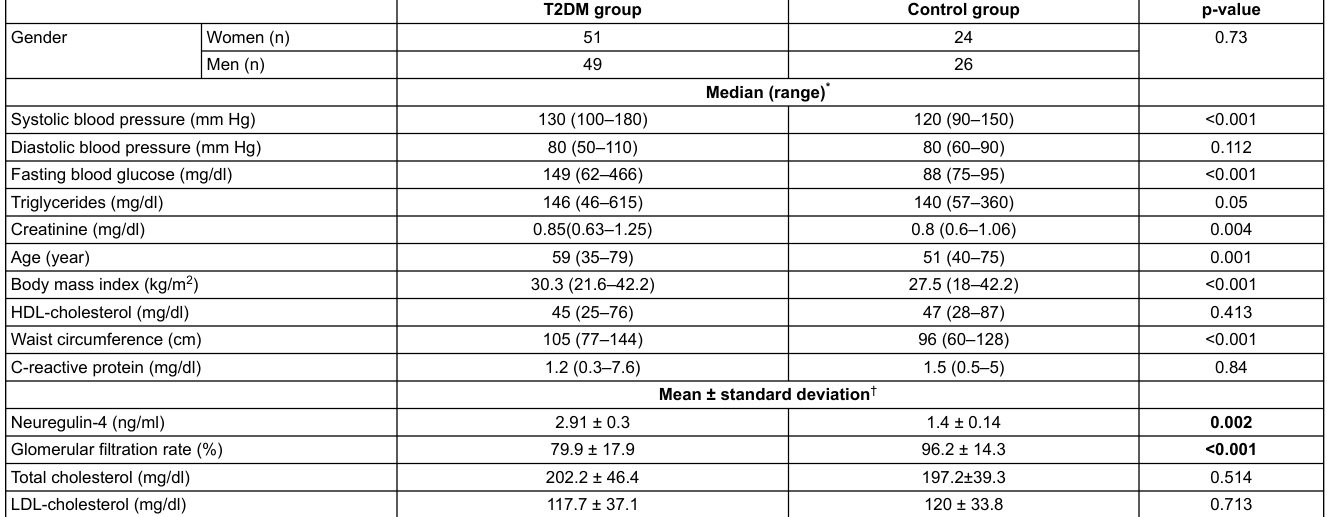
Table 1: Comparison of the characteristics and laboratory data between the type 2 diabetes and control groups.